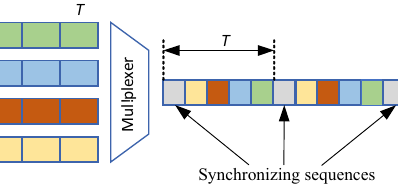
Figure 1. Wavelength-division multiplexing.